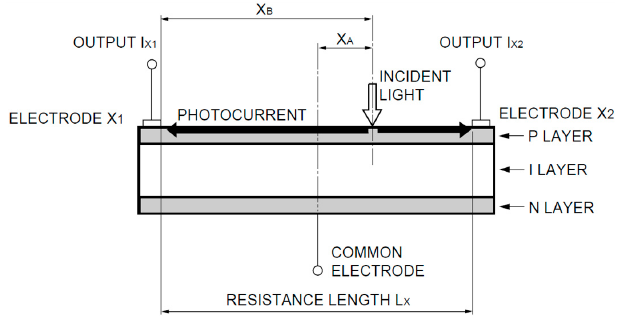
Figure 2. Section of a one-dimensional PSD (image courtesy of Hamamatsu, obtained from the PSD technical information).